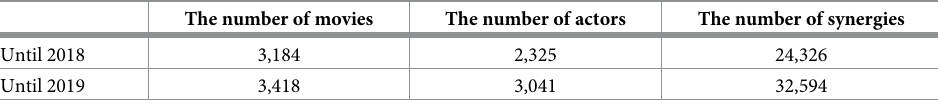
Table 1. Summary of